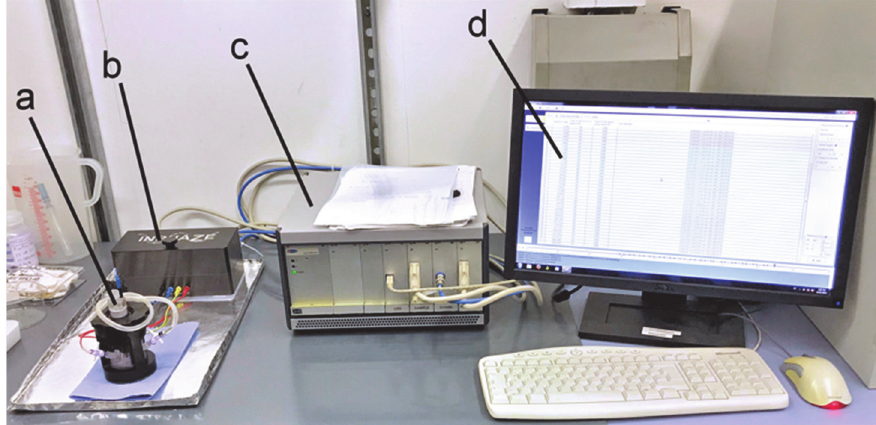
Figure 3. Electrochemical impedance spectrometry set-up; (a) EIS cell, (b) amplifier unit with reference circuit, (c) impedance spectrometer unit and (d) PC for analyser and measurement control software.